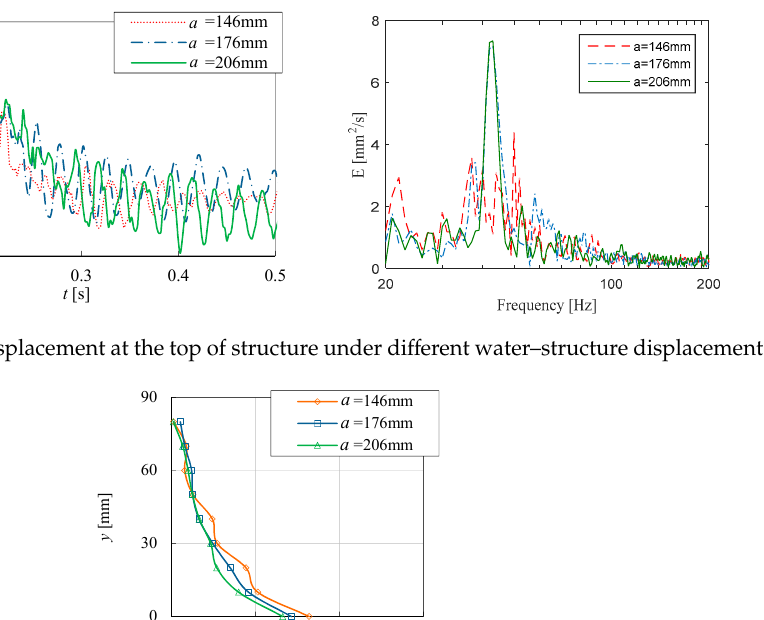
Figure 10. Vertical distribution of wave pressure for the structure under different water–structure displacement.